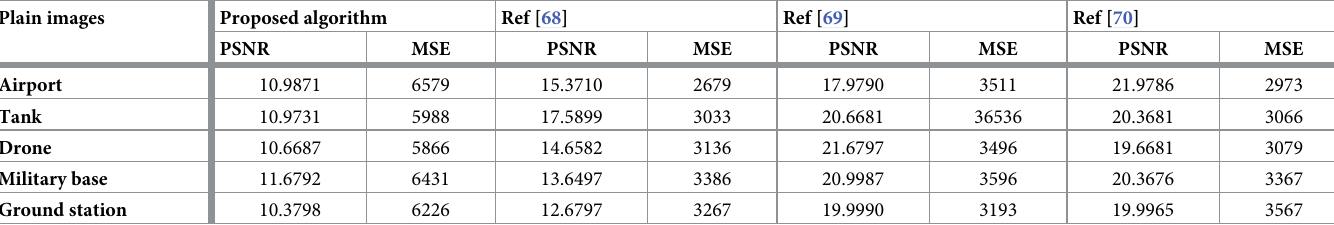
Table 13. MSE and PSNR